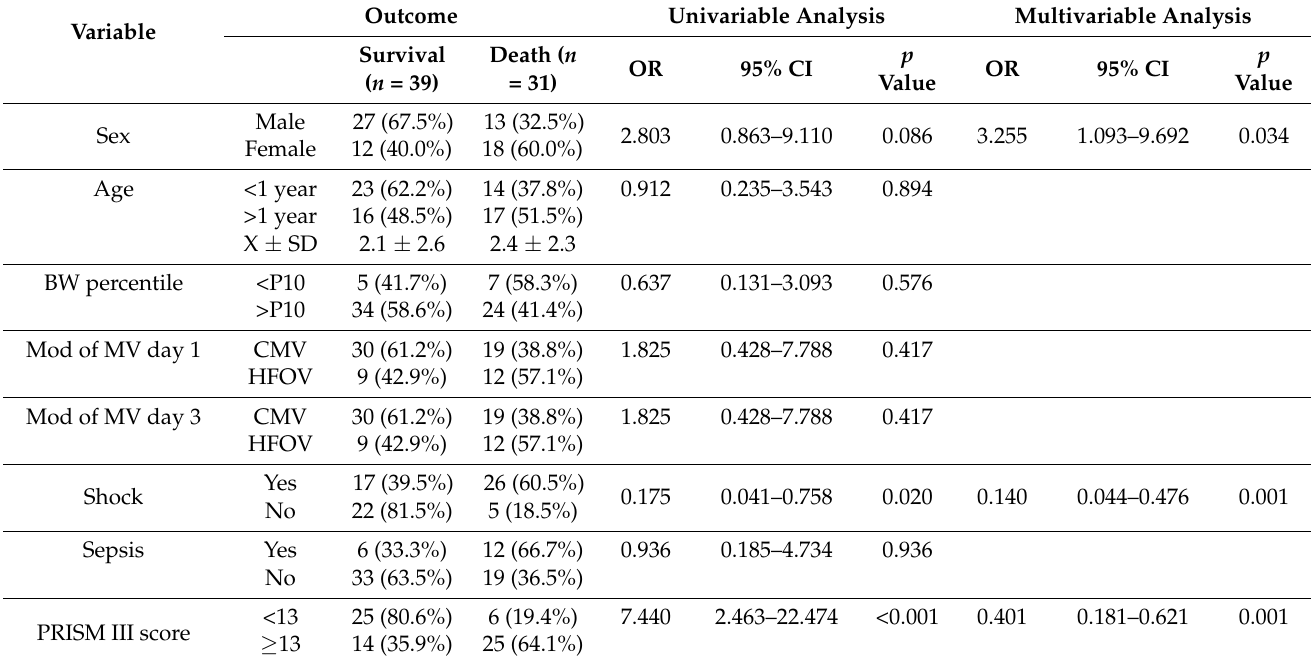
Table 2. Correlation of patient data and mechanical ventilation mode—statistical examination.